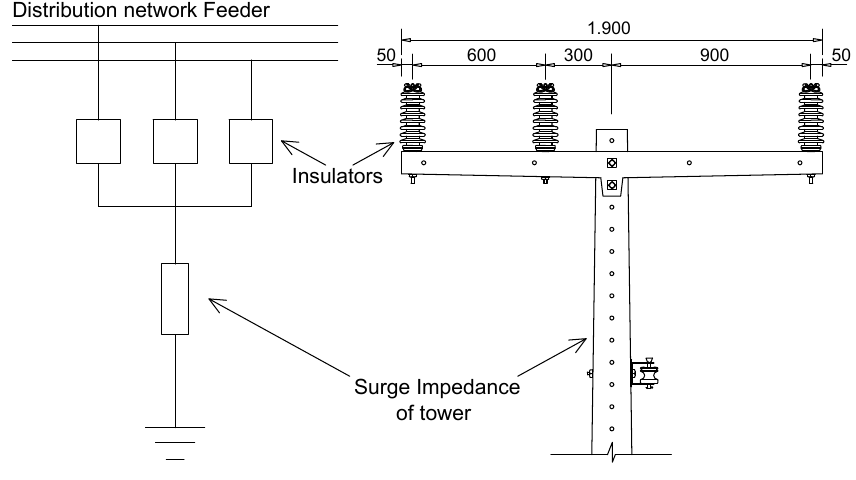
Figure 2. Elements of the type P1